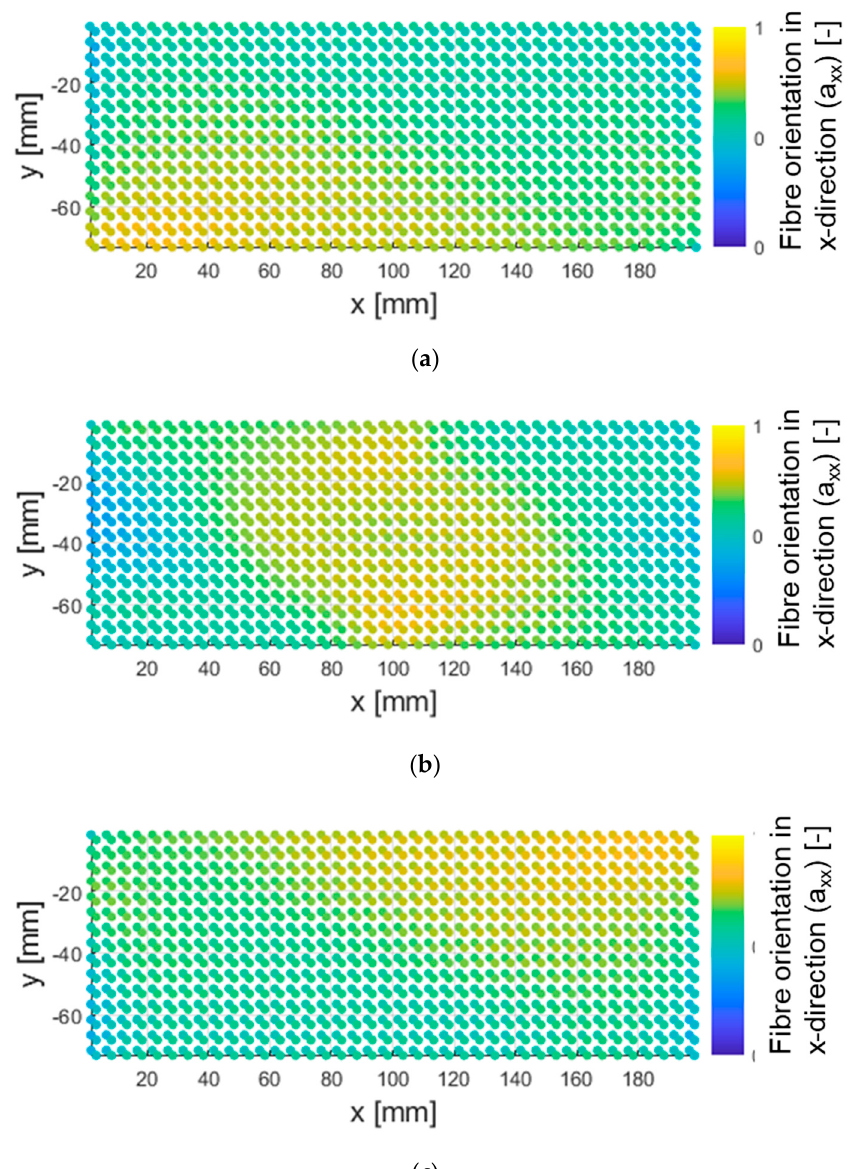
Figure 8. Comparison of fibre orientation in the x-direction for the three preform validation geometries obtained by process simulation. ( a ) = Validation geometry 1; ( b ) = Validation geometry 2; ( c ) = Validation geometry 3.